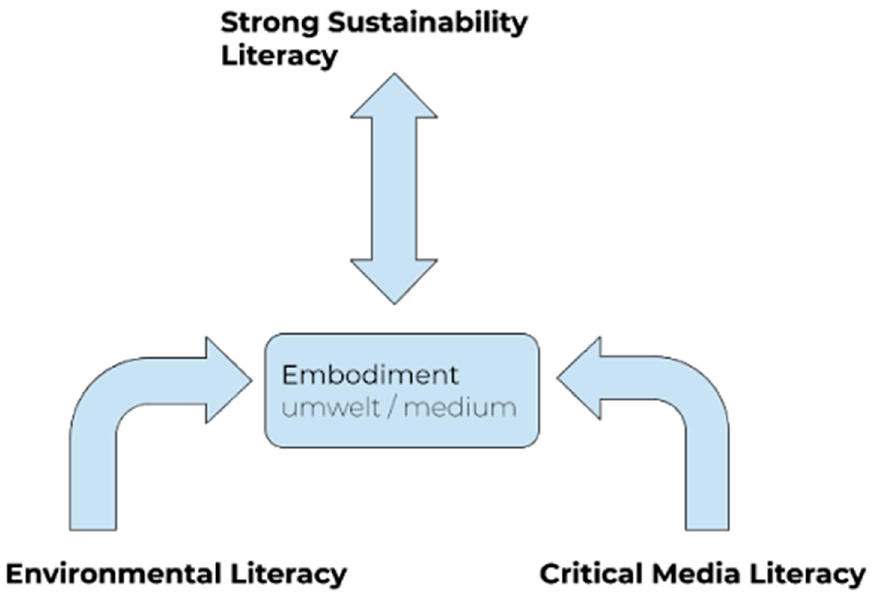
Figure 1. “Strong Sustainability” literacy .